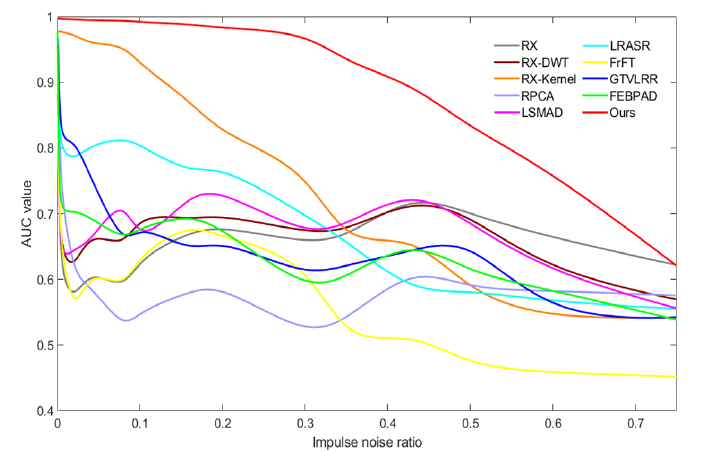
Figure 17. The AUC results on the AVIRIS-I dataset with different degrees of interference of im- pulse noise.